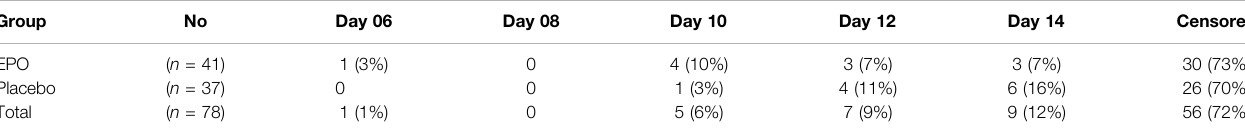
TABLE 7 | Number of patients achieving complete re-epithelialization.